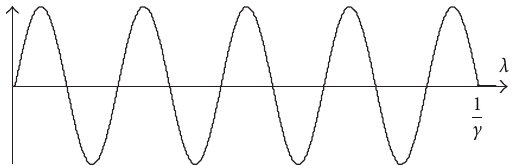
Figure 11: The simplified ℎ(𝑡) (named ℎ 𝑆 (𝑡) ): there is no damping at 0 < 𝑡 < 1/𝛾 , but for 𝑡 > 1/𝛾 , it is identically zero, that is, we first ignore the damping of the real ℎ(𝑡) and then cut it completely. This idealization expresses the undoubted fact that the interval 0 < 𝑡 < 1/𝛾 is dominant and makes the treatment simpler. A small change in 1/𝛾 which makes the oscillatory part more pleasing by including in it just the (closest) integer number of the half waves, as shown here, may be allowed, and when using ℎ 𝑆 (𝑡) in the following we shall assume for simplicity that the situation is such.